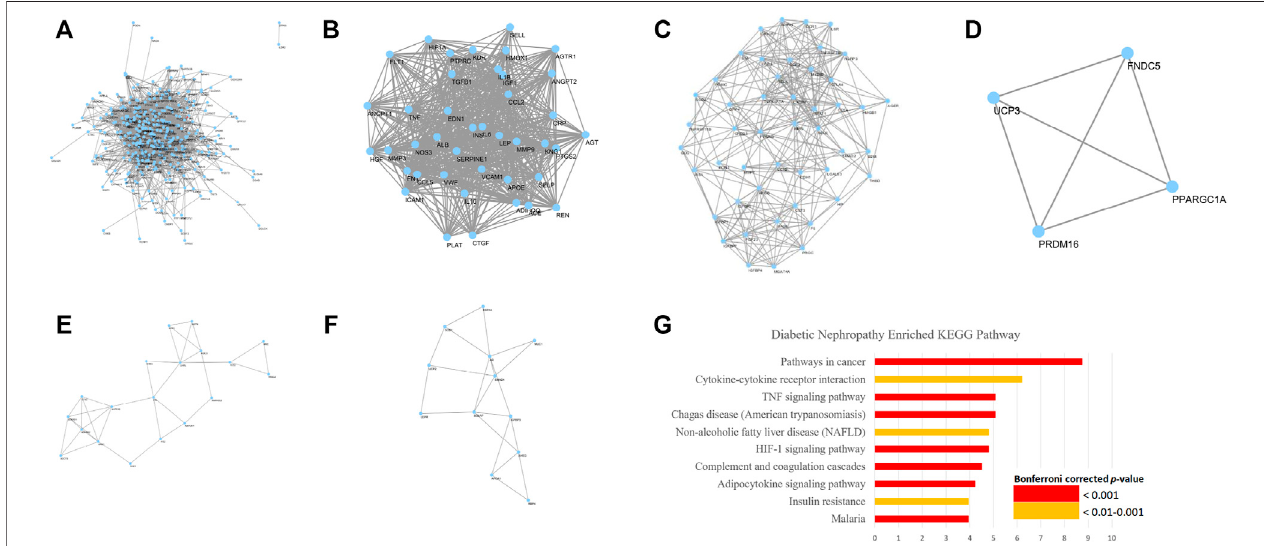
FIGURE 2 | Network and representative clusters of DN. Key pathogenesis of DN includes the complement and coagulation cascades, adipocytokine signaling pathway,TNFsignaling pathway, HIF-1signaling pathway, and AMPK signaling pathway. (A) Atotalof9,621pairsofgeneswereidenti fi edfromGeneCardsand OMIM. (B – F) Major Cluster of Genes Related to Diabetic Nephropathy and (G) KEGG enrichment analysis on the DN